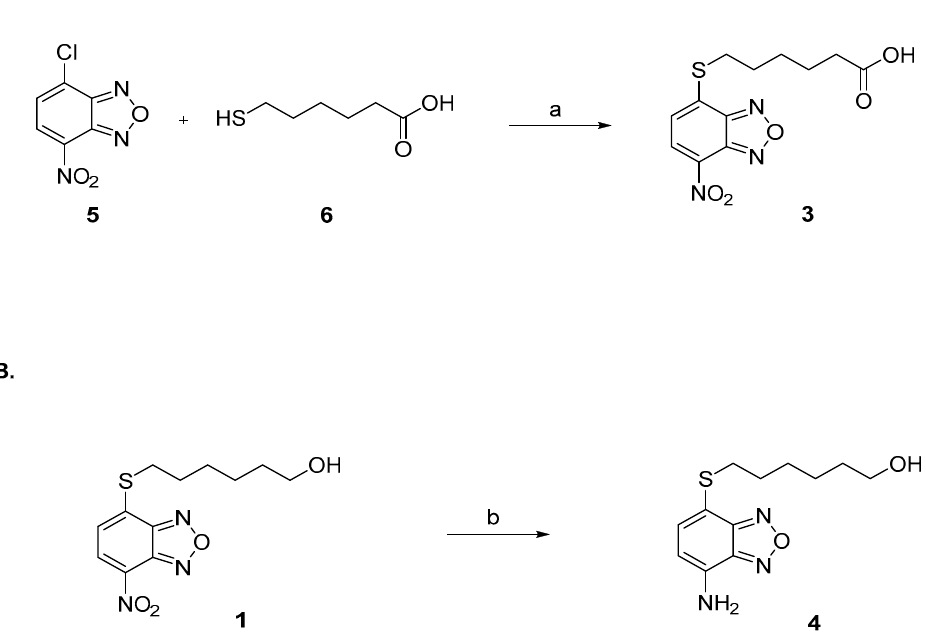
Figure 5. ( A ) Reagents and conditions: (a) NaHCO3 0.5 M, THF, r.t. ( B ) Reagents and conditions: (b) Fe powder, HCl 12 N, DCM, MeOH, r.t.